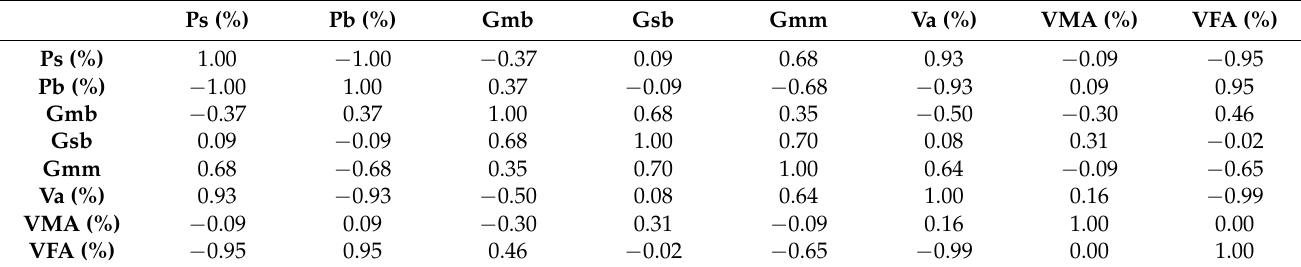
Table 2. Correlation of input parameters for AWC.